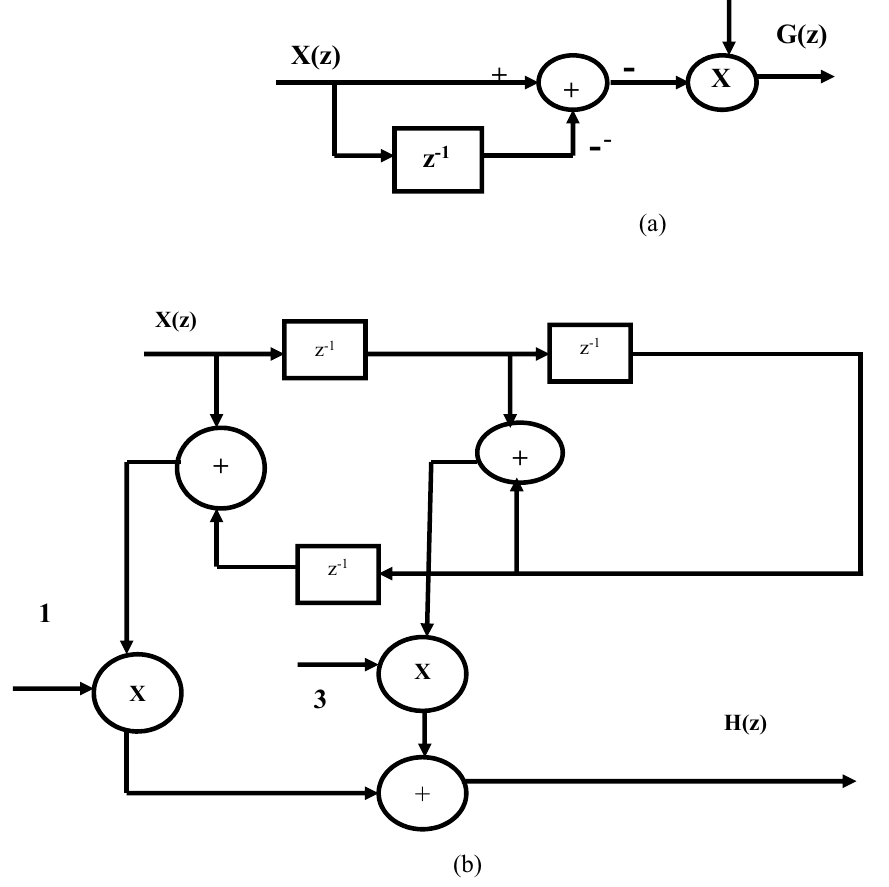
Figure 5. Linear phase realization of ( a ) HPF and ( b )